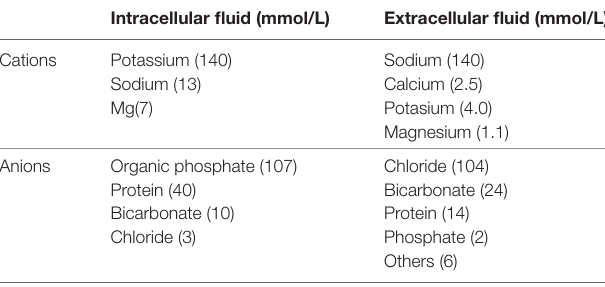
TABLe 3 | Average solute concentrations in intracellular and extracellular compartments